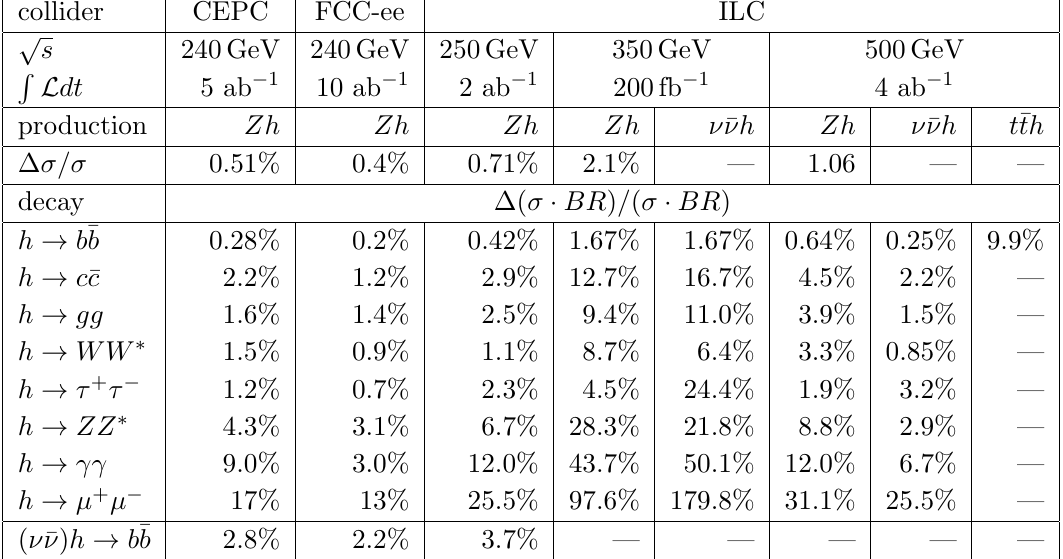
Table 1 . Estimated statistical precisions for Higgs measurements obtained at the proposed CEPC program with 5 ab (cid:0) 1 integrated luminosity [1], FCC-ee program with 10 ab (cid:0) 1 integrated luminos- ity [2], and ILC with various center of mass energies